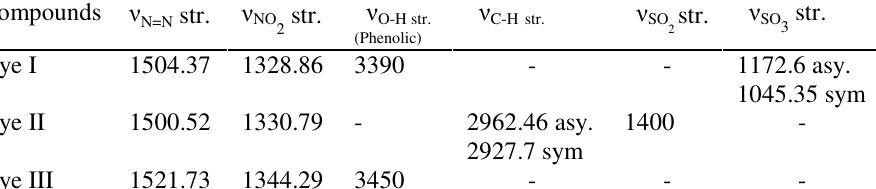
Figure 2 . IR Spectrum for dye I